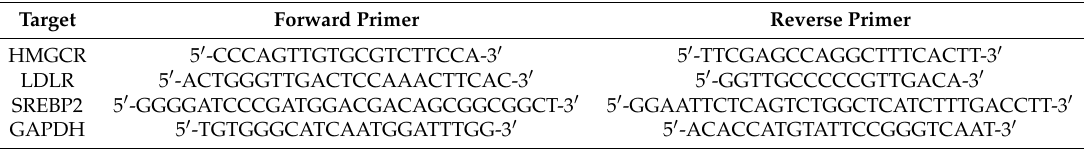
Table 1. Quantitative real-time polymerase chain reaction primer